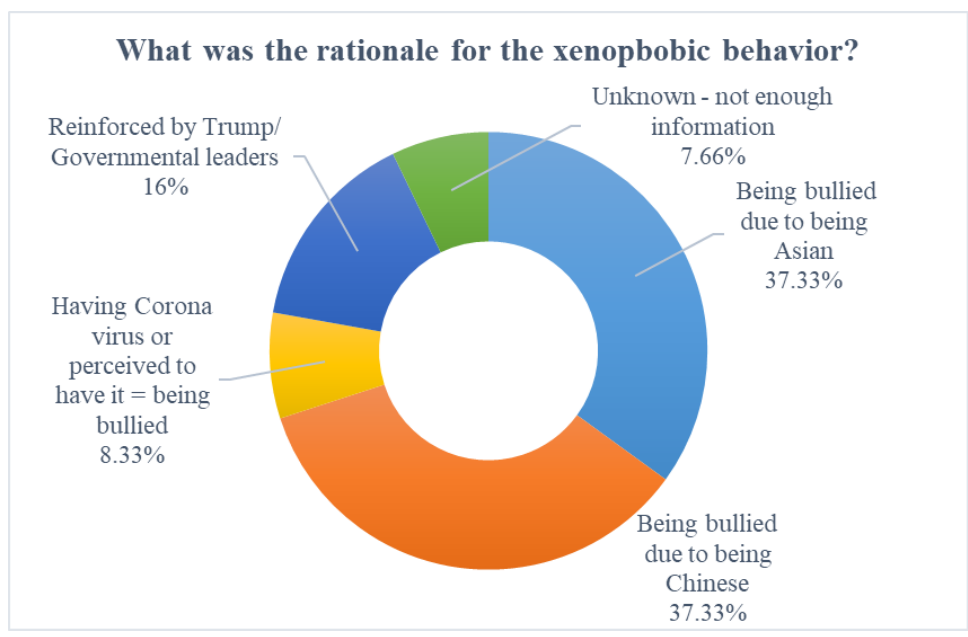
Figure 4. Rationale for xenophobic behavior.